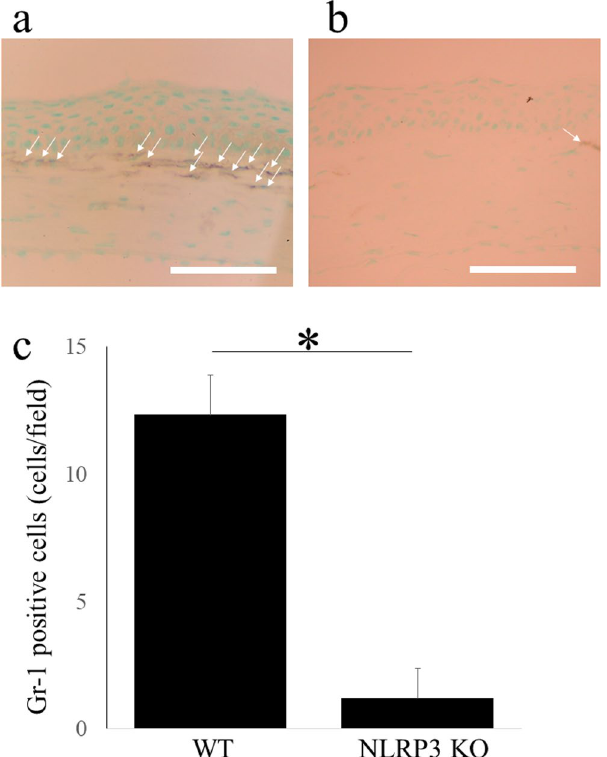
Figure 7. Neutrophil accumulation after LPS application is diminished in NLRP3 KO mice. Gr-1-positive cells (arrows), which account for neutrophil, are infiltrated in anterior stroma of WT mice 2 days after LPS application. ( a ) In NLRP3 KO mice ( b ), this accumulation is canceled, and the Gr-1-positive cells are significantly fewer compared with those of WT mice (N = 3 each, WT mice; 12.3 ± 1.5 cells/field, NLRP3 KO mice; 1.2 ± 1.1 cells/field, P < 0.01, ManneWhitney U -test) ( c ). Bar = 40 μ